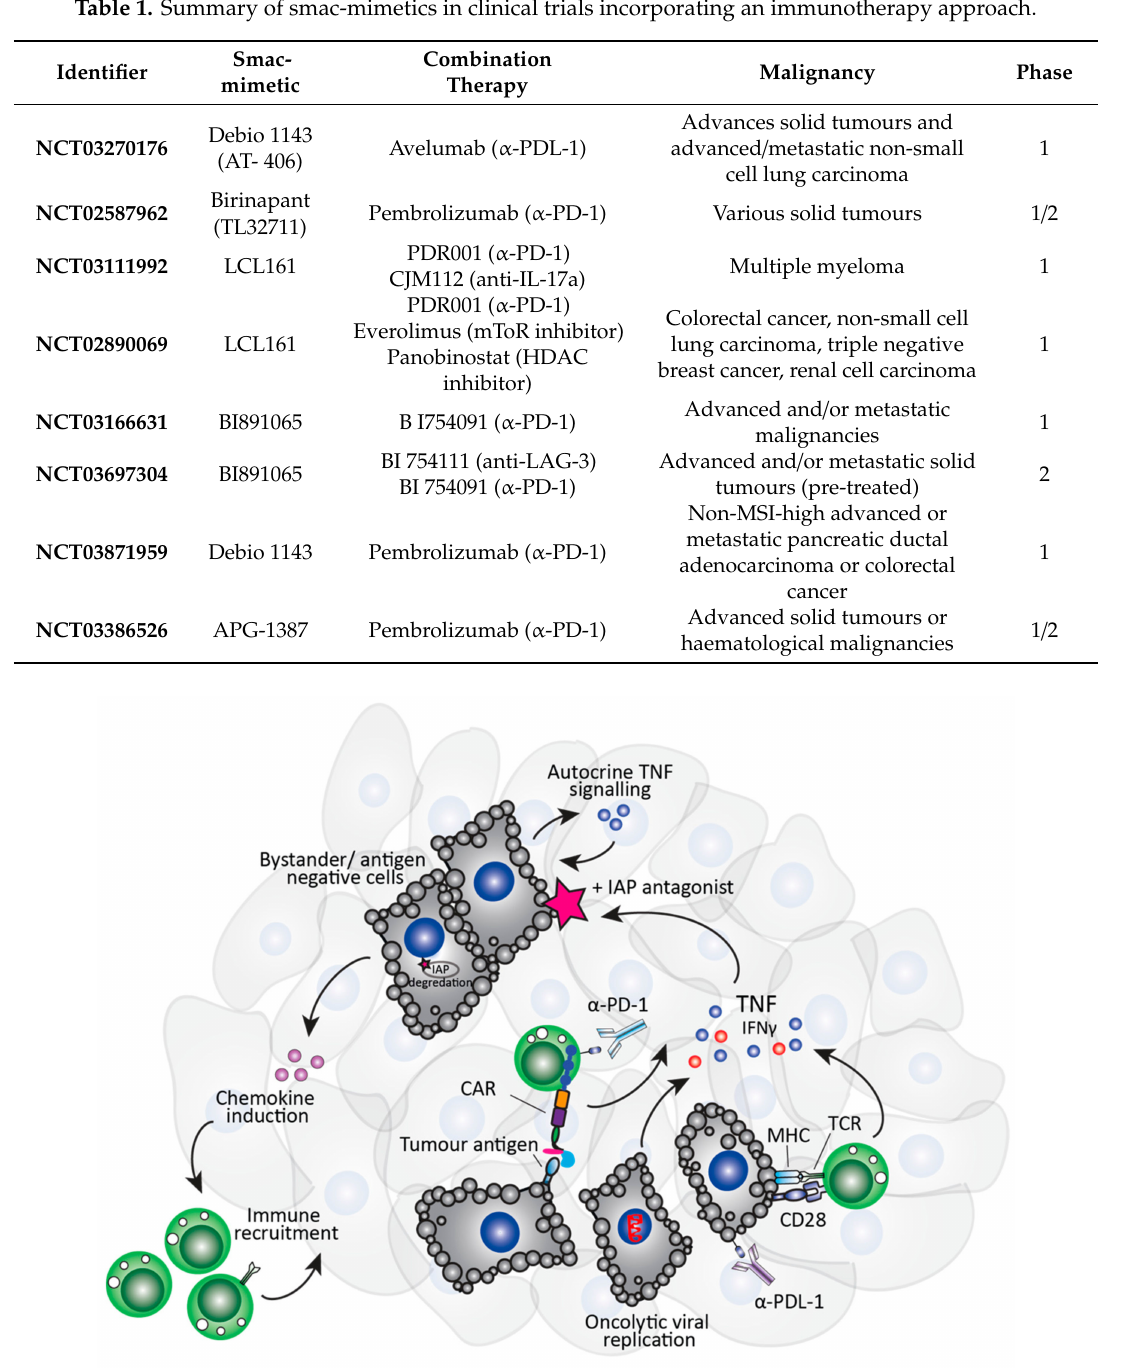
Figure 2. Bystander killing mediated by tumour cell IAP antagonism. TNF released following checkpoint blockade, CAR T cells, or from tumour cells following oncolytic virus-induced death can cause death of surrounding “bystander” tumour cells, due to IAP